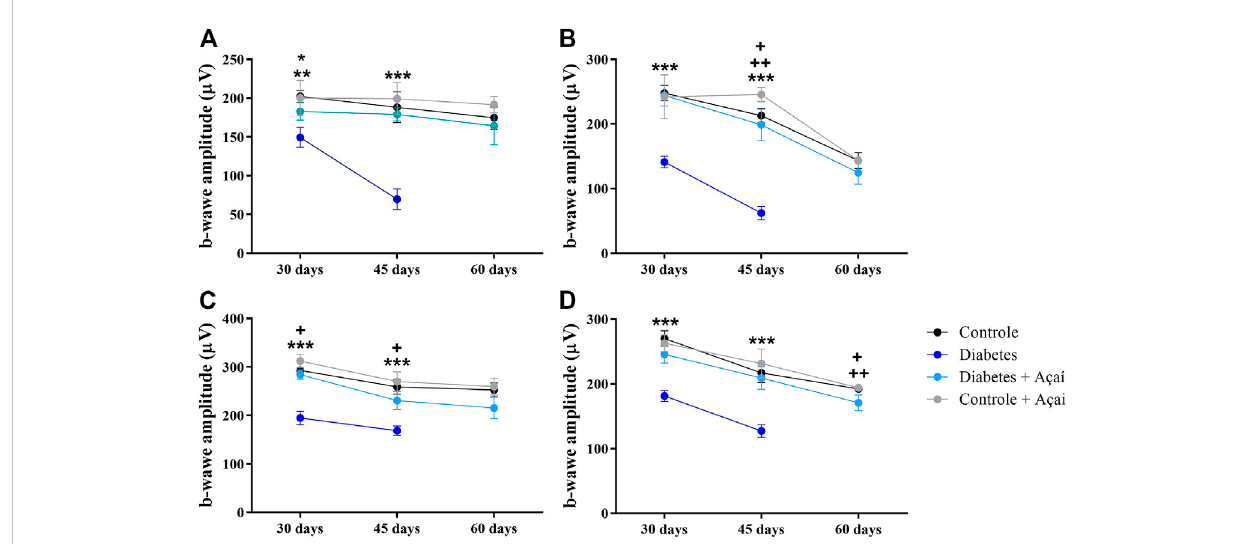
FIGURE 4 Full fi eld electroretinogram b-wave amplitude s monitoring after diabetes induction. Values are means ± SD. (A) Scotopic response (Rods): ** p < 0.001 CTR and CTR + Açaí vs. DM in 30 days; * p < 0.01 DM + Açaí vs. DM in 30 days; *** p < 0.0001 CTR, CTR + Açaí and DM + Açaí vs. DM in 45 days; + p < 0.01 CTR + Açaí vs. CRT and DM + Açaí in 45 days (B) Scotopic combined response (Mix 1): *** p < 0.0001 CTR, CTR + Açaí and DM + Açaí vs. DM in 30 days;*** p < 0.0001CTR,CTR+AçaíandDM+Açaívs.DMin45 days;+ p < 0.01 CRTvs.CTR+Açaíin45 days;++ p < 0.01DM+Açaívs.CTR+ Açaíin45 days (C) Scotopic combinedresponse (Mix2):*** p < 0.0001CTR, CTR+Açaíand DM+ Açaívs.DMin30 days; + p < 0.01 DM+Açaívs.CTR + Açaíin30 days;*** p < 0.0001CTR,CTR+AçaíandDM+Açaívs.DMin45 days;+ p < 0.01DM+Açaívs.CTR+Açaíin45 days (D) Coneresponse:*** p